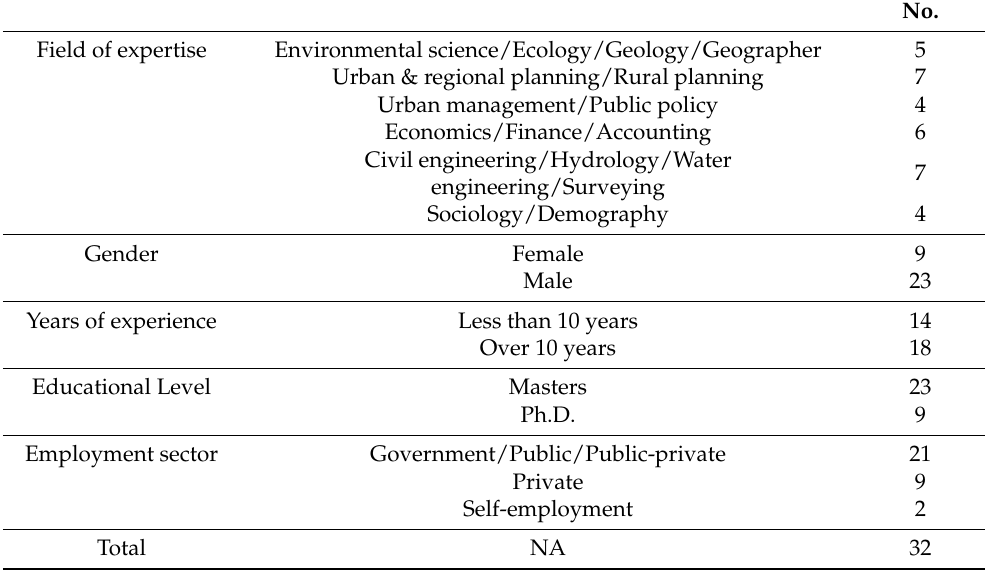
Table 4. Background information of experts.